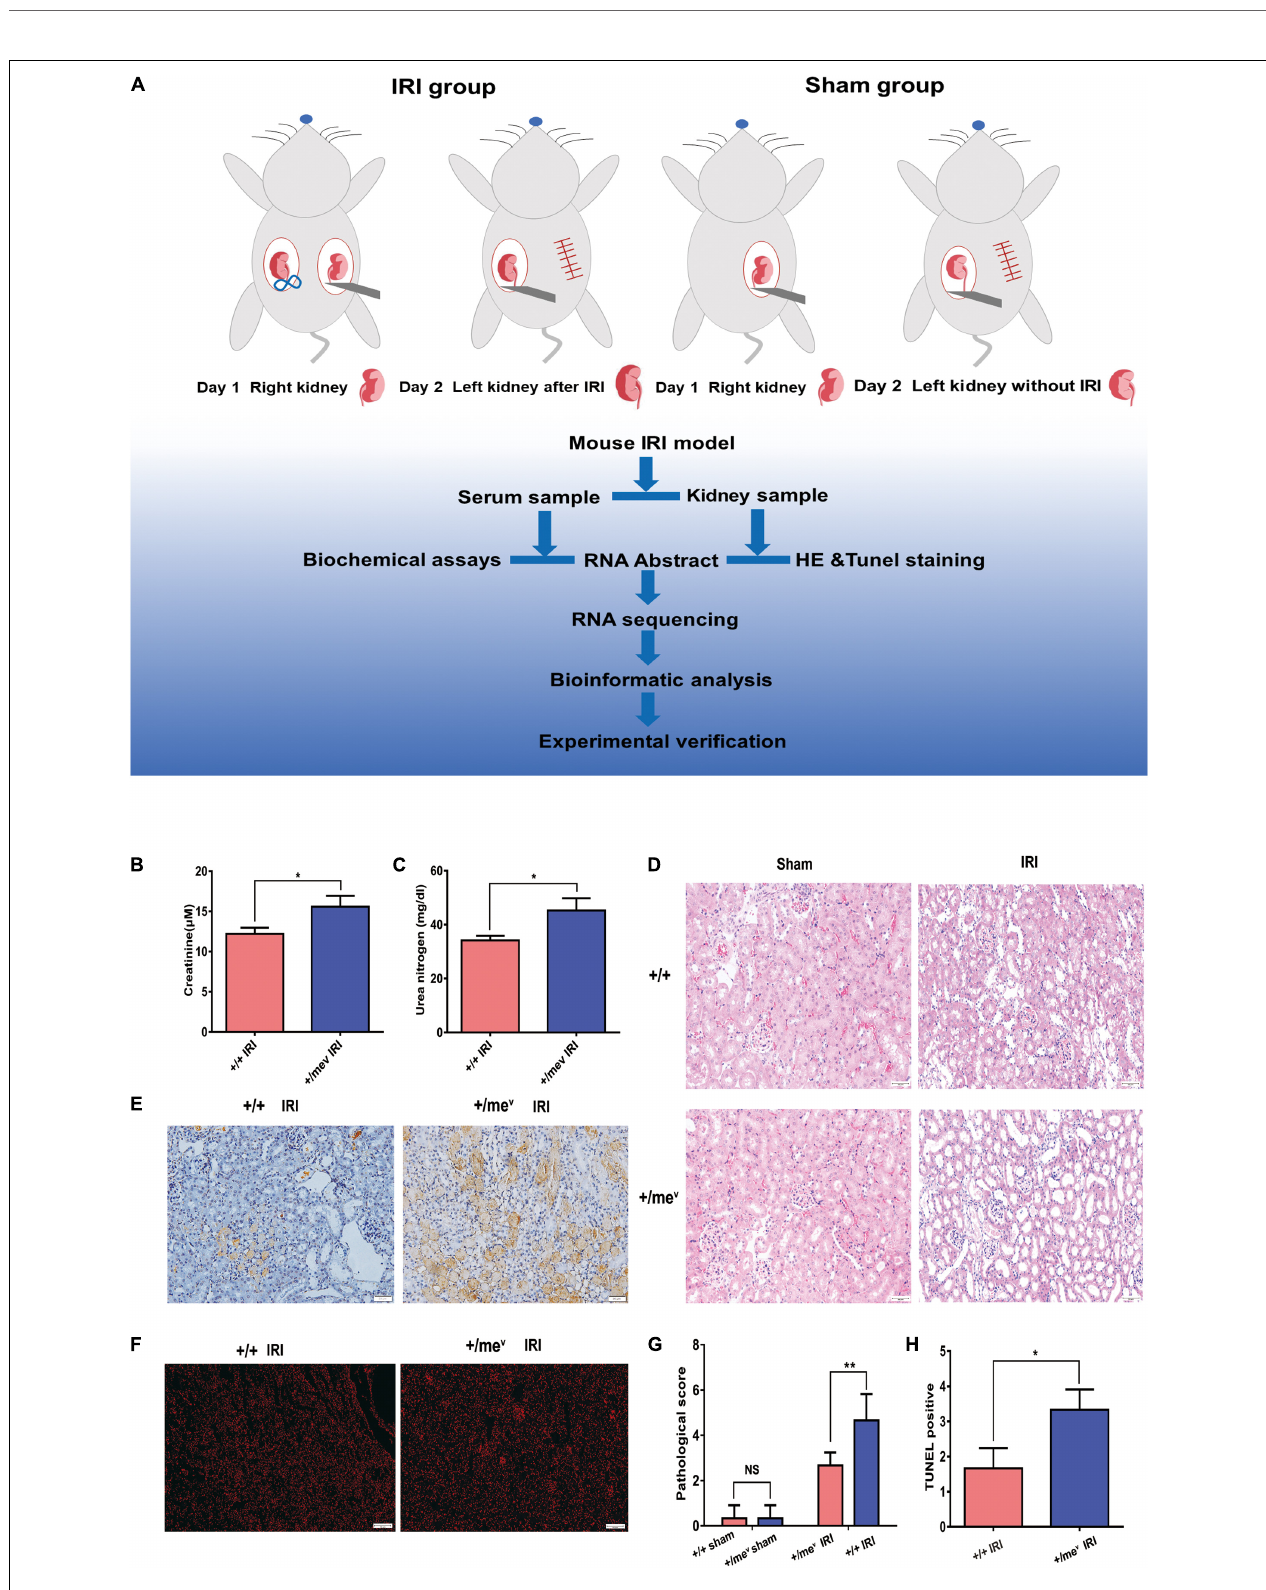
FIGURE 1 | SHP-1 insufficiency in vivo aggravated renal IRI and increased apoptosis. (A) The steps involved in the establishment of the mouse renal IRI model and analysis process. Briefly, the control group and the heterozygous mice underwent unilateral nephrectomy. After right nephrectomy, the left kidney was